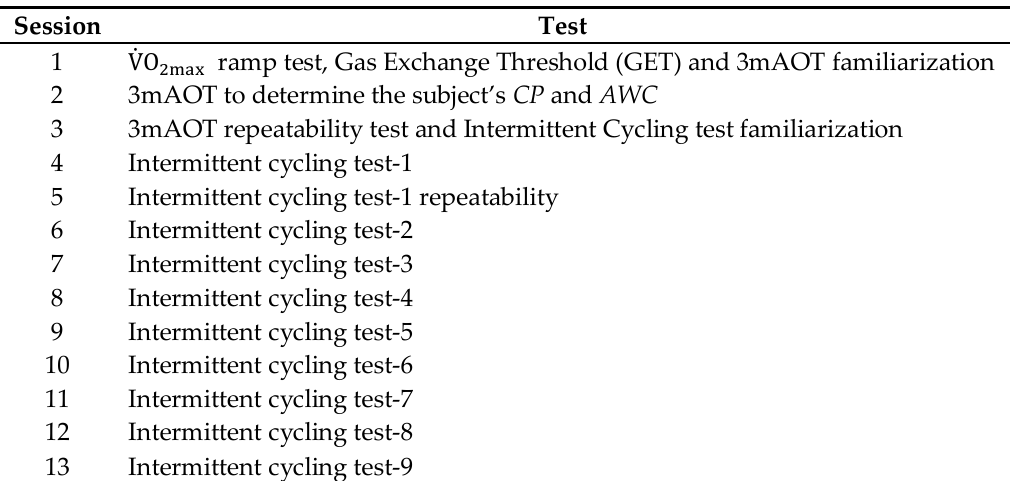
Table 1. Day-wise testing plan.